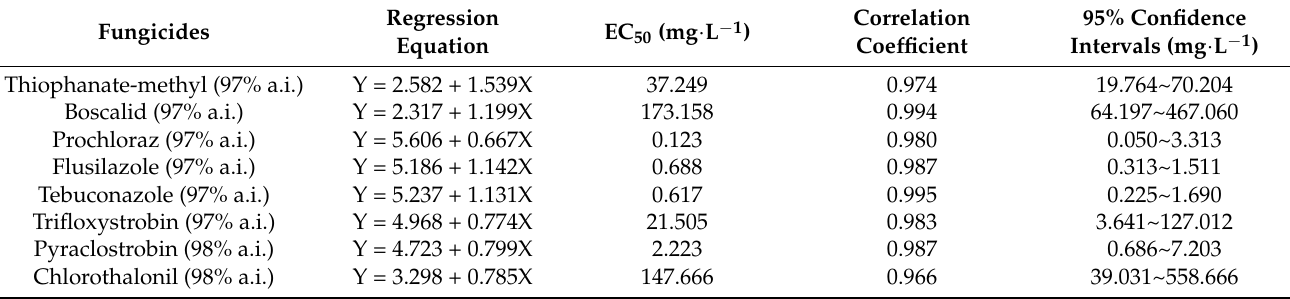
Table 5. Antifungal activities of fungicides against F. acuminatum